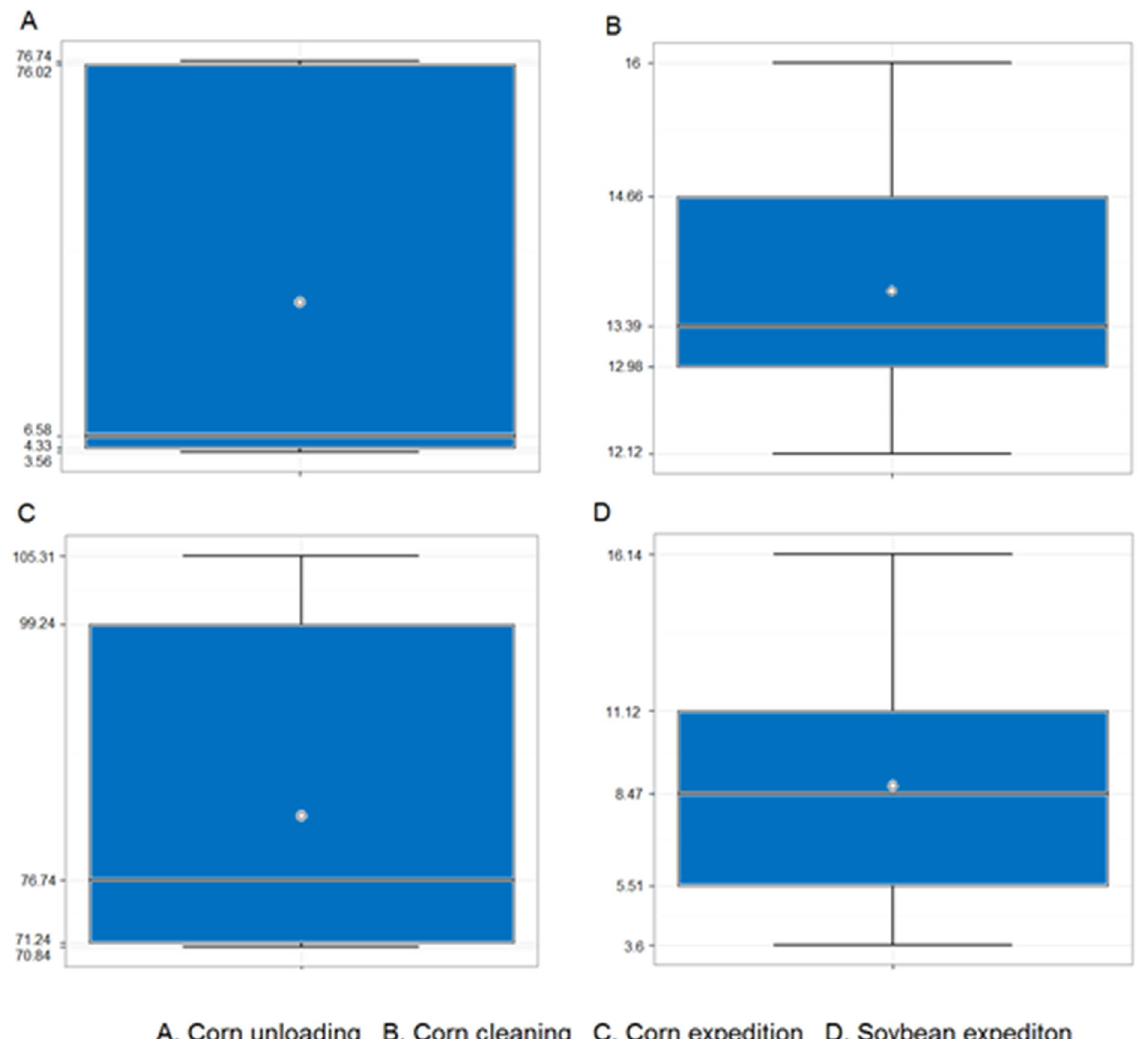
Figure 7. Total dust measurement on Upper Confidence Limit (UCL), average and Lower Confidence Limit (LCL) at corn unloading ( A ), corn cleaning ( B ) operation, corn expedition ( C ) and soybean expedition ( D